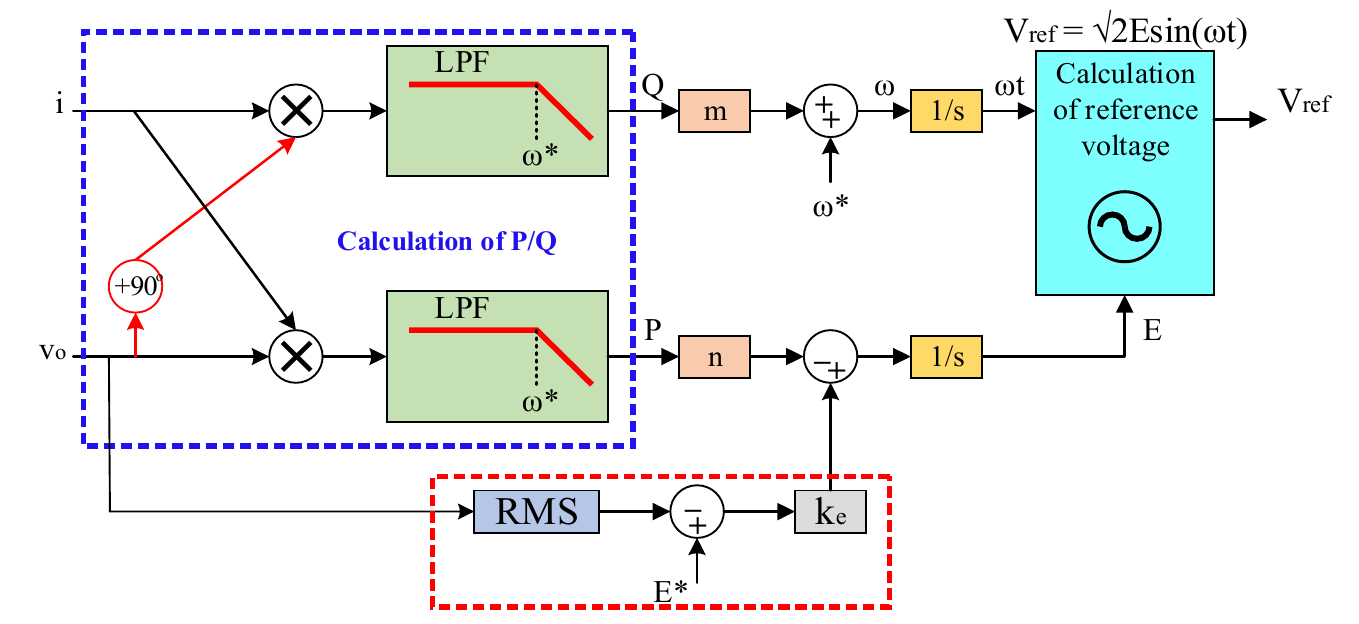
Figure 8. Modified droop control system.